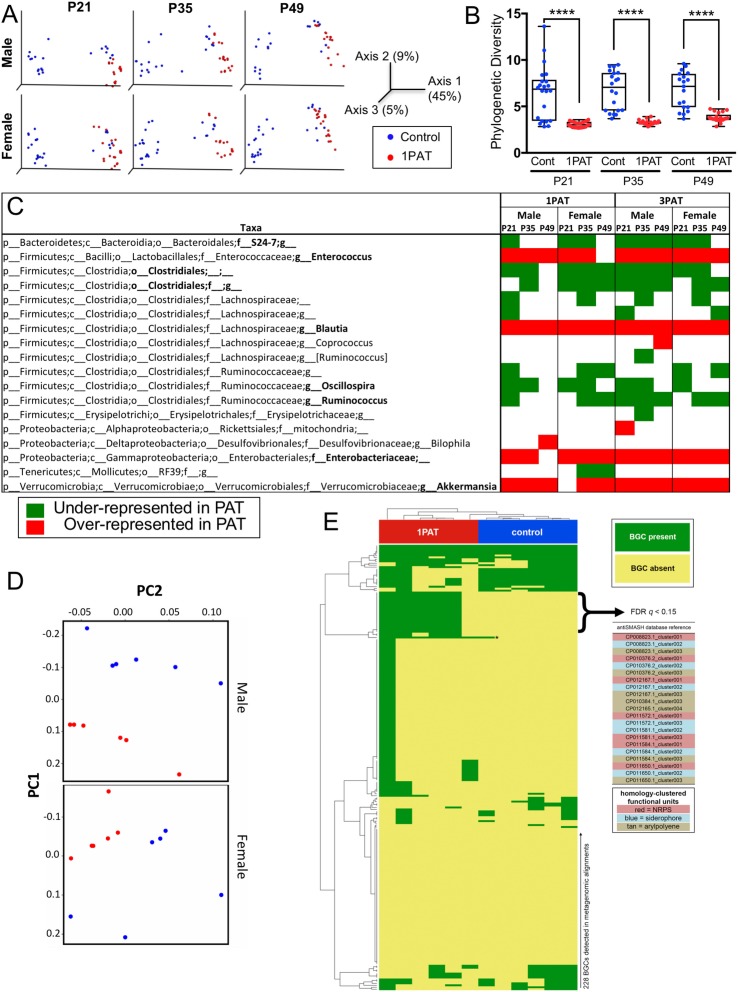
Early-life fecal microbiota in PAT and control NOD mice.(A) β-diversity, as determined by unweighted UniFrac analysis of control and1PAT fecal microbiota over time, analyzed by QIIME2. Inter- and intra-group UniFrac distances were all significant (p<0.0001), determined by one-way-ANOVA with Tukey correction for multiple comparisons. (B) α-diversity (Phylogenic diversity (PD)) of fecal microbiota in control and 1PAT males. Statistical significance determined by one-way-ANOVA test. ****p<0.0001. (C) Early-life taxa significantly under- or over-represented in 1PAT and 3PAT mice compared to controls, by ANCOM in QIIME2. Fecal specimens were obtained at P21, P35, and P49 from male and female mice, exposed or not to 1PAT or 3PAT (n = 20–25 mice per group). (D) Metagenomic (MetaCyc) pathway distribution in male and female mice at P21, visualized by principal component analysis (PCA; blue, control; red, 1PAT, n = 6 samples per group). (E) Comparison of BGC content in male 1PAT and control metagenomic P21 samples. Presence (blue) or absence (gold) heat map of the 228 detected BGCs in male 1PAT (green) vs. control (purple) mice, generated by using an accelerated optimal gapped alignment algorithm against a BGC database (Al-Ghalith and Knights, 2017; Blin et al., 2017; Needleman and Wunsch, 1970). For visualization and dendrograms, axes are clustered by average linkage. For each of the 228 BGCs shown, a Fisher’s exact test was performed on a contingency table of 1PAT/control vs. BGC presence/absence. Filtering to an FDR q < 0.15 yielded 22 uncharacterized BGCs enriched in 1PAT vs. control mice, and an Enterococcus polysaccharide pathway, indicated by ‘*'. Similarity-based clustering using custom Python and C code collapses the 22 uncharacterized BGCs to three functional groups (indicated in table by color) annotated to the family Enterobacteriaceae, encoding putative aryl polyene, NRPS (nonribosomal peptide synthetase), and siderophore pathways. [See also Figure 2—figure supplements 1–11, and Supplementary file 1].10.7554/eLife.37816.018Figure 2—source data 1.Values of alpha diversities and beta diversities.